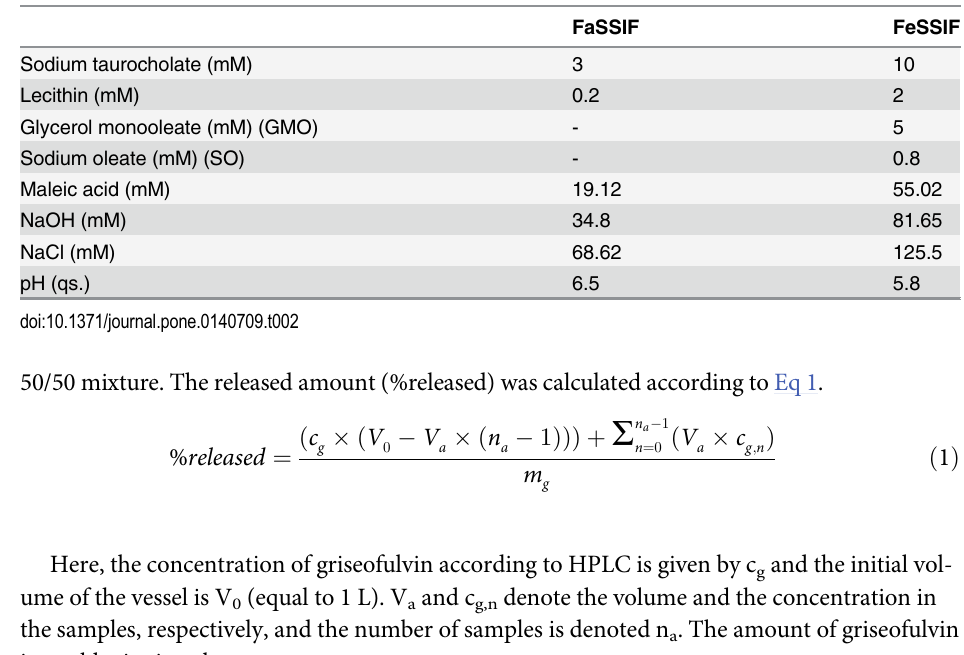
Table 2. Compositions of dissolution medium.